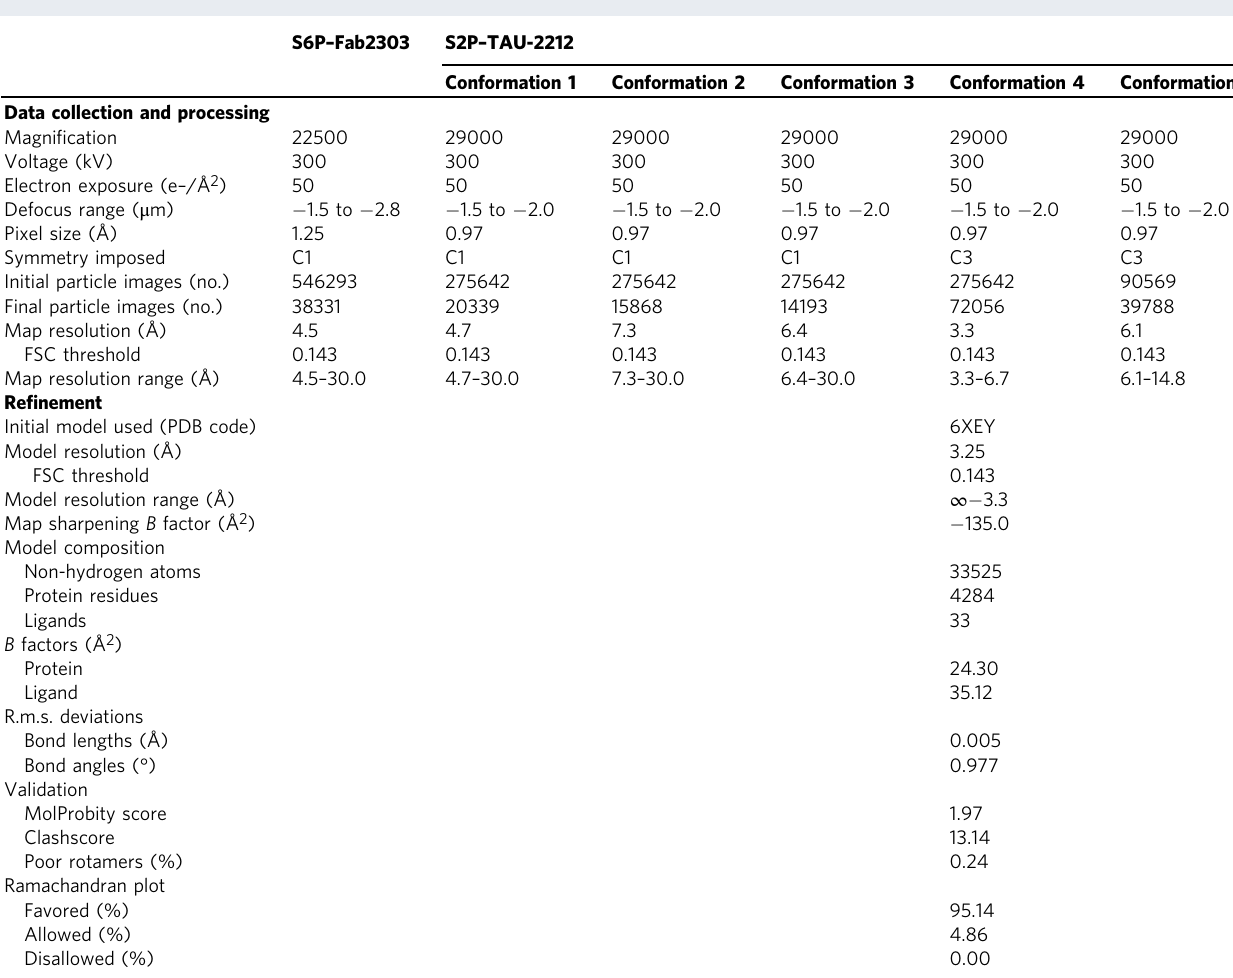
Table 2 Cryo-EM data collection, re fi nement and validation statistics for spike – Fab2303 and spike –